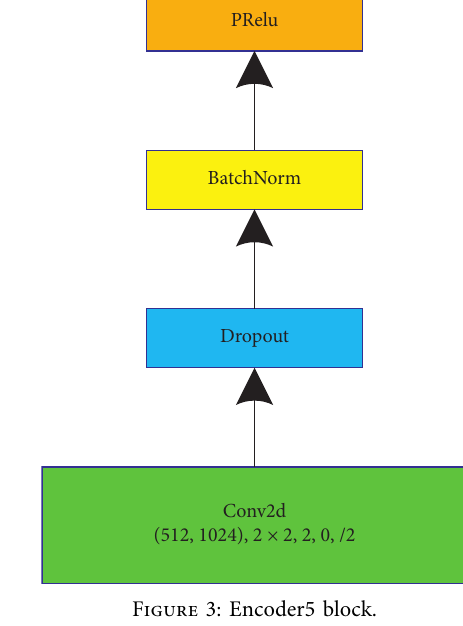
Figure 3: Encoder5 block.